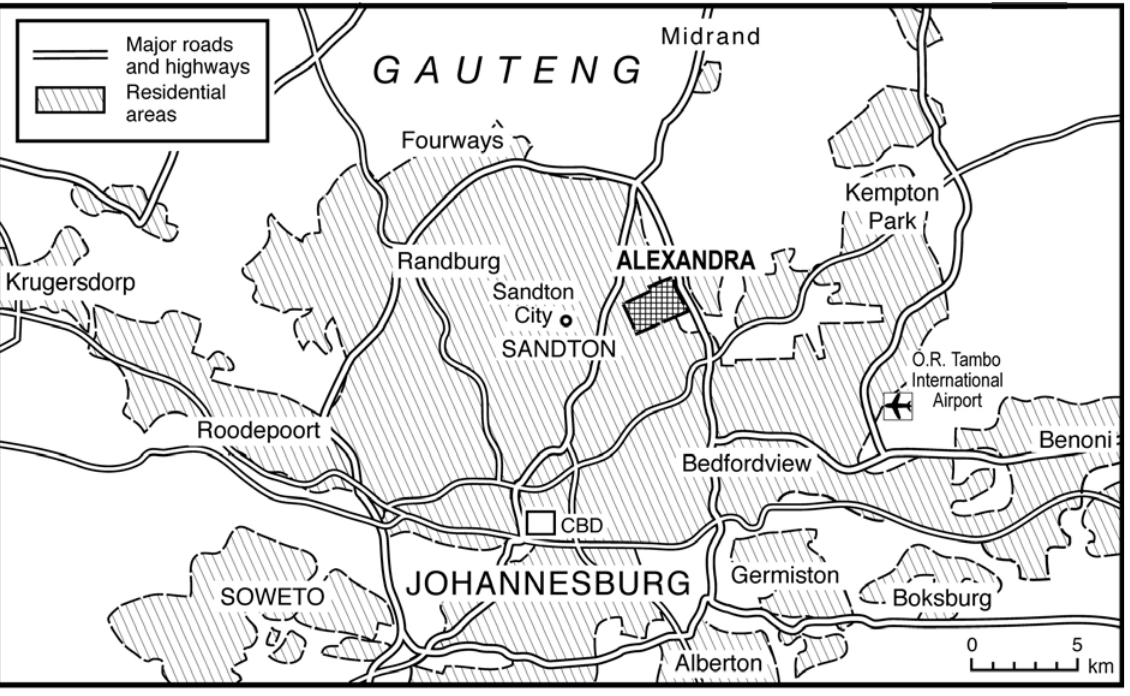
Figure1: Location of Alexandra township within the City of